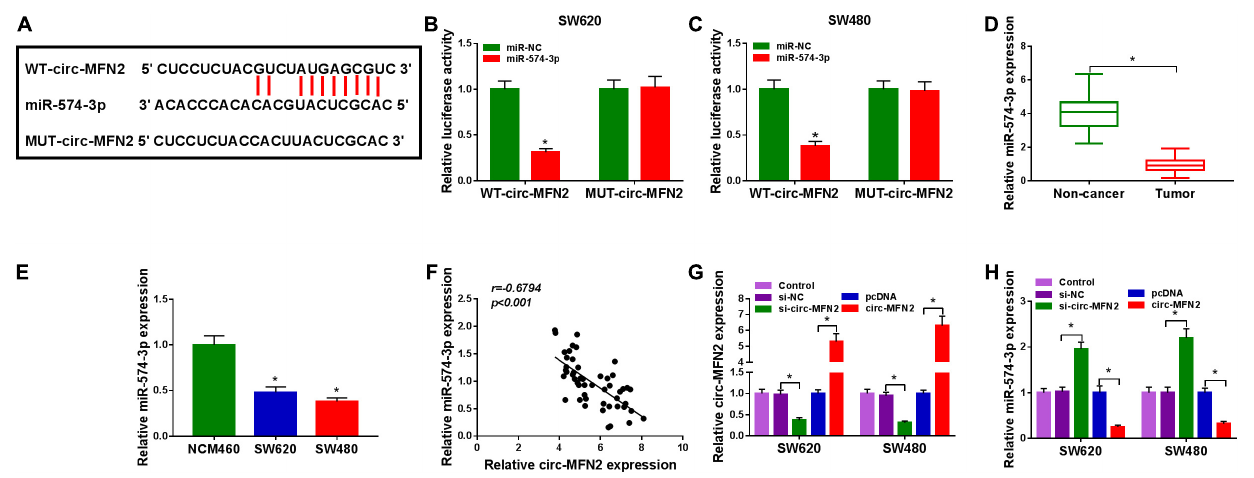
FIGURE 4 | Circ-MFN2 directly interacted with miR-574-3p. (A) The predicted and mutated binding sites between circ-MFN2 and miR-574-3p were shown. (B,C) Dual-luciferase reporter assay was used to verify the interaction between circ-MFN2 and miR-574-3p. (D) The expression of miR-574-3p in CRC tumor tissues and non-cancer tissues was measured using qRT-PCR. (E) QRT-PCR was used to detect the miR-574-3p expression in CRC cell lines (SW620 and SW480) and NCM460 cells. (F) Pearson correlation analysis was used to assess the correlation between circ-MFN2 and miR-574-3p. (G) The transfection efficiencies of si-circ-MFN2 and pcDNA circ-MFN2 overexpression plasmid were confirmed using qRT-PCR. (H) QRT-PCR was employed to detect the expression of miR-574-3p to assess the effect of circ-MFN2 on miR-574-3p expression. * P < 0.05.